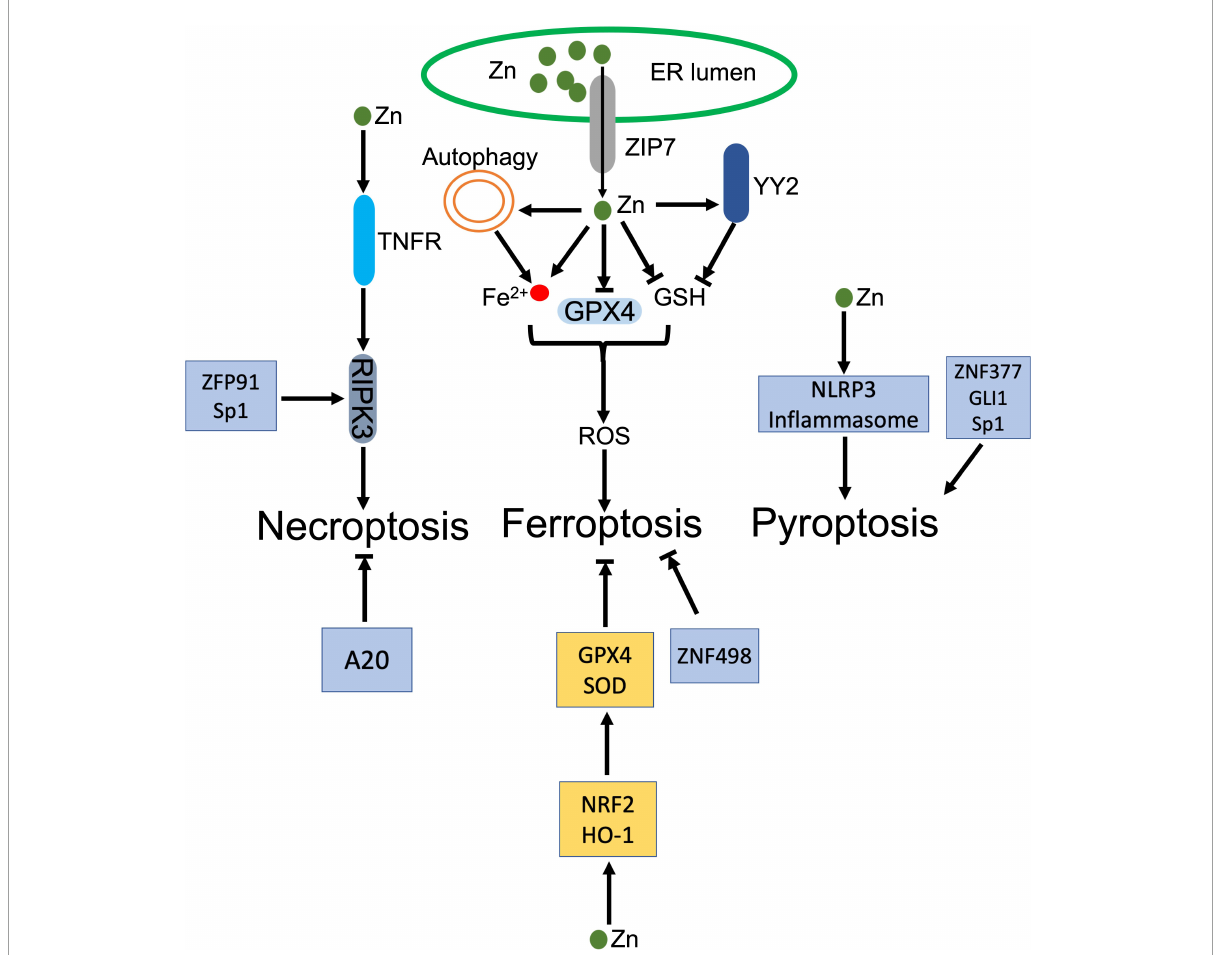
FIGURE4 Dual roles of zinc (Zn) in regulated necrosis. ZIP transports Zn from ER to cytosol, which increases Zn level in cytoplasm. The increased Zn inhibits GPX4 and its cofactor GSH, and disturbs the intracellular iron homeostasis, which jointly trigger the accumulation of ROS and lead to ferroptosis. In addition, Zinc finger protein, YY2 inhibits GSH, which also activates ferroptosis. Besides ferroptosis, Zn and zinc finger proteins, ZFP91 and Sp1, facilitate activation of RIPK3 dependent necroptosis. Meanwhile, Zn activates NLRP3 inflammasome. Zinc finger proteins, ZNF377, GLI1, and Sp1 also induce pyroptosis. In the contrary, Zn upregulates GPX4 and GSH through NRF2 and HO-1 to counteract ferroptosis. ZNF498 and A20 also antagonize ferroptosis and necroptosis,